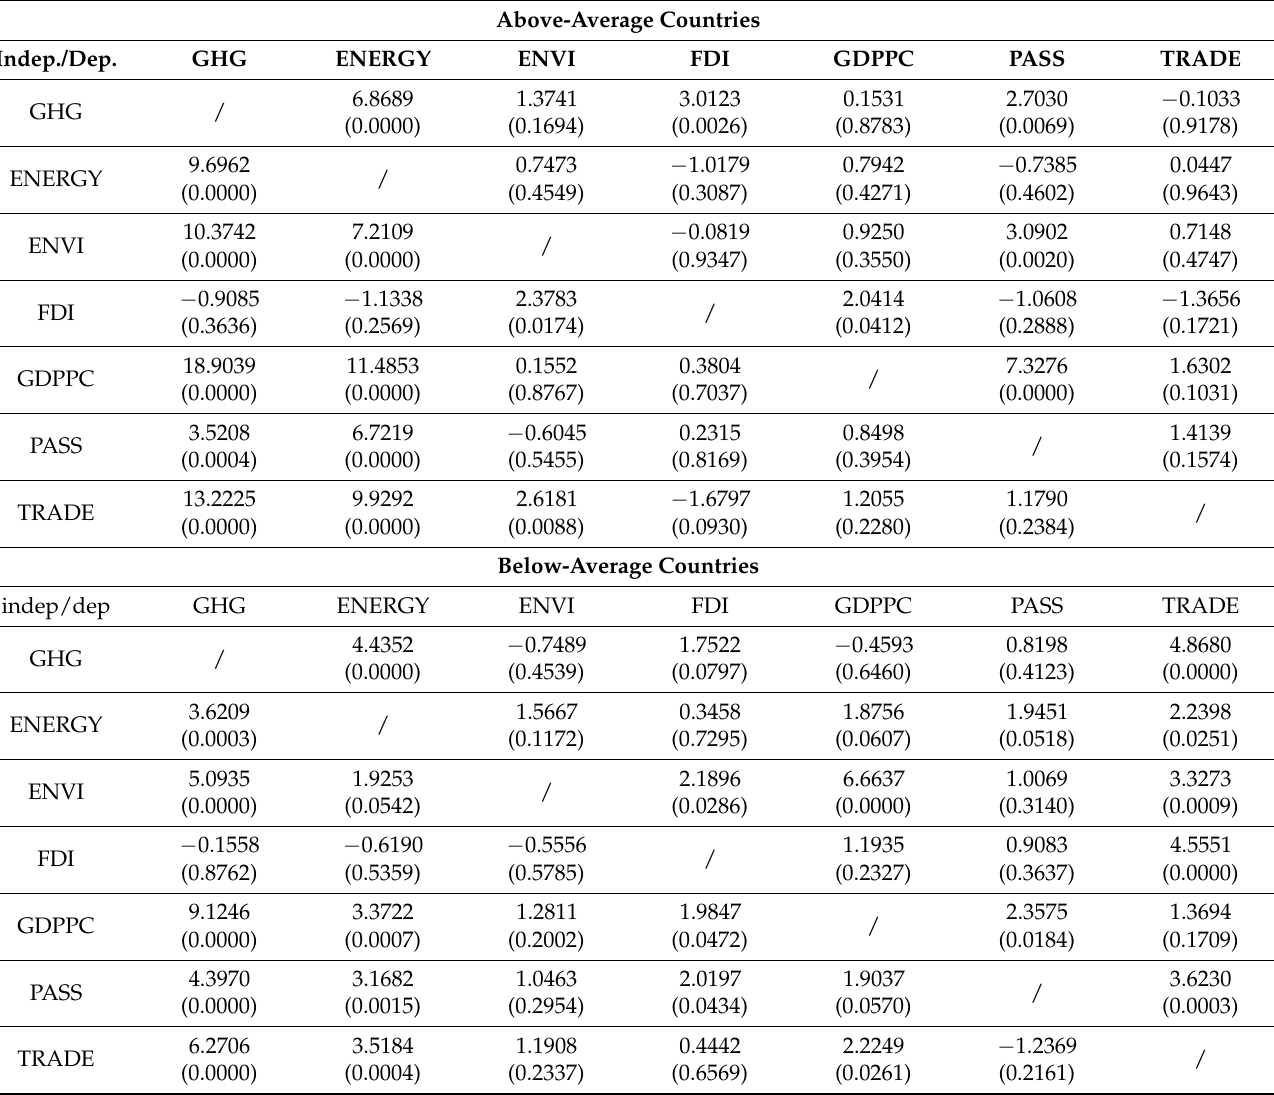
Table 6. Granger causality test results. Source: